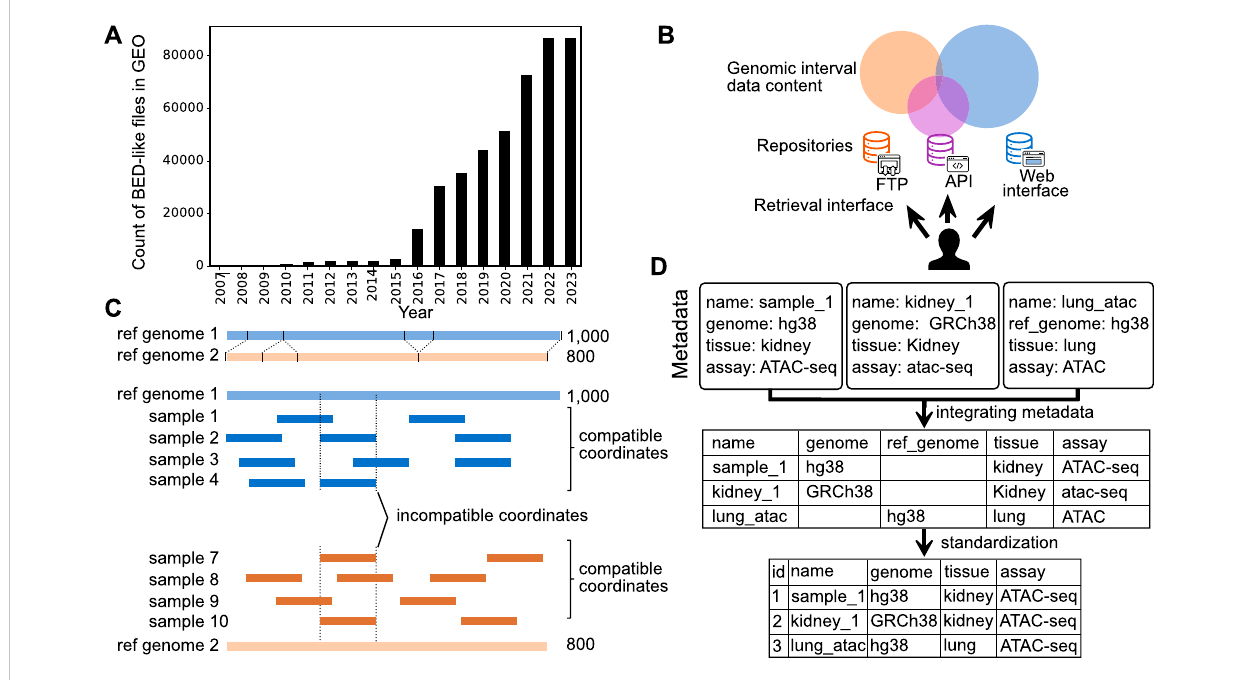
FIGURE 1 Overview of challenges in sharing and reusing genomic interval data. (A) Growth in number of BED-like fi les in GEO ( fi les on either GEO series or sample entries with names including bed, bigBed, narrowPeak, or broadPeak, and size less than 25 mb). (B) Illustration of identifying and retrieving genomic interval data among fragmented repositories with different data retrieval mechanisms. (C) Demonstration of the challenge to integrating genomic interval data across different reference genomes. (D) Integration of metadata with and without